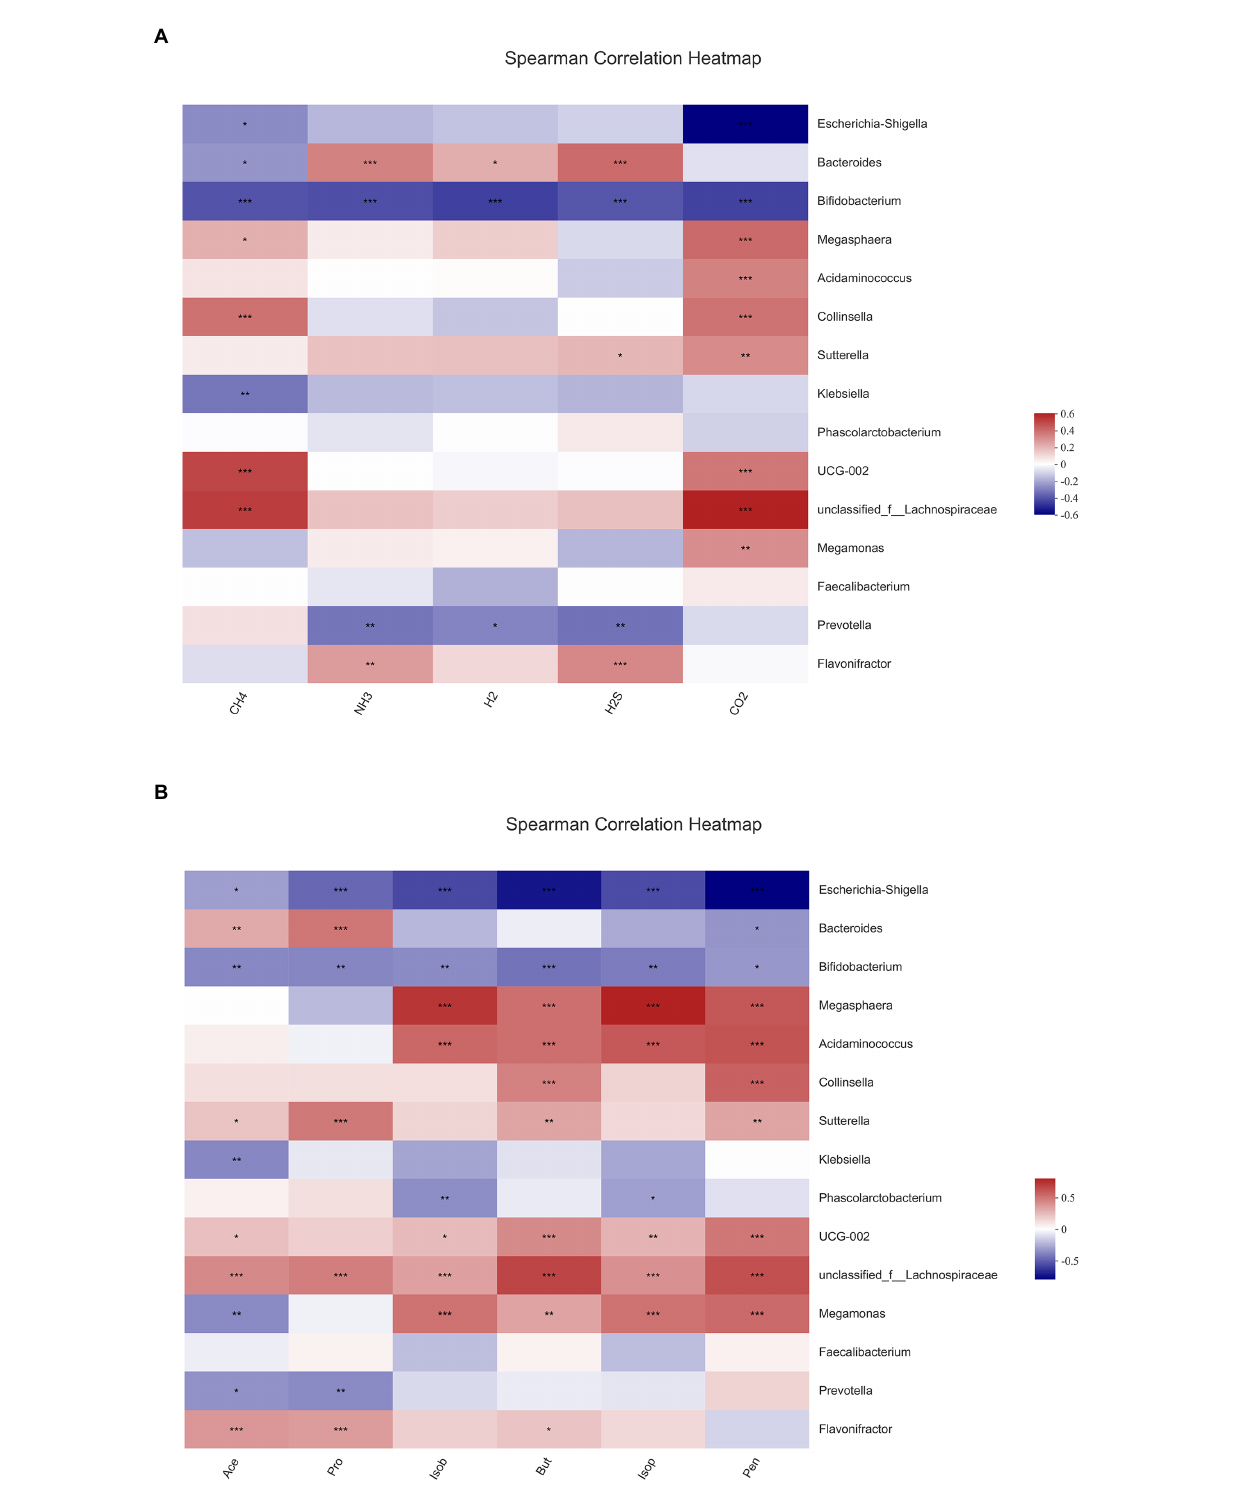
FIGURE 8 Correlation analysis between gut microbiota and gas (A) , short-chain fatty acids and (B) in fermentation samples. Data are means ± SEM (10 independent experiments). * 0.01 < p ≤ 0.05, ** 0.001 < p ≤ 0.01, *** p ≤